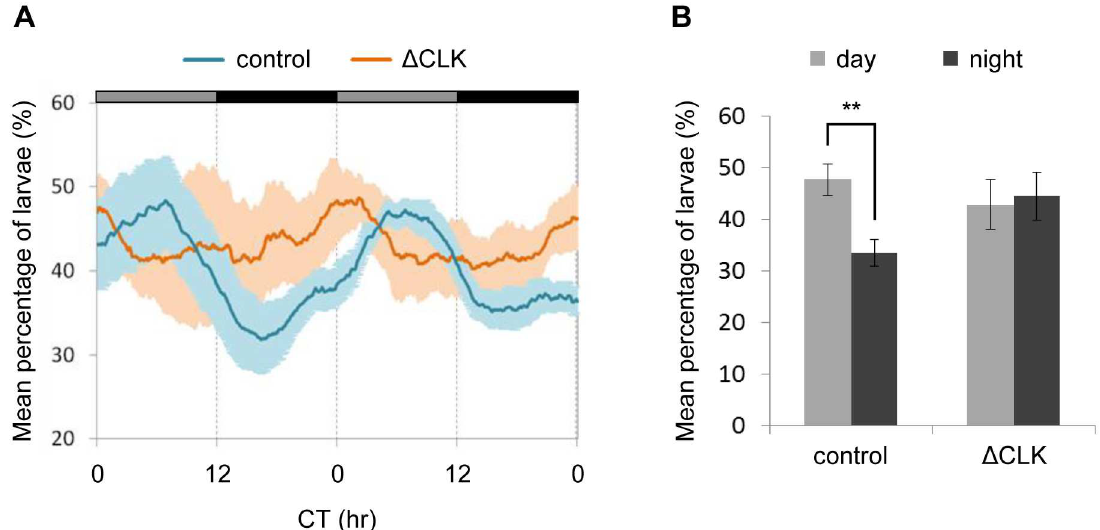
Fig 8. Clock-controlled rhythms of place preferenceare eliminated by blocking the pineal clock. Analysis of the vertical position of Tg( aanat2 :EGFP- Δ CLK) and control larvae in the water column for two daily cycles under DD, after entrainment by 4 LD cycles. (A) The mean percentage of larvae within the top third of the water column is plotted on the y-axis and circadiantime (CT) is plotted on the x-axis. Error bars represent SE [ n = 4 groups of 15 Tg( aanat2 :EGFP- Δ CLK) larvae, and 8 groupsof 15 control larvae]. Gray and black horizontal bars represent subjective day and subjectivenight, respectively.A significant difference in distribution of the G-factors (see ’Fourier analysis’in S1 Text) was revealedbetweenTg( aanat2 :EGFP- Δ CLK) and control larvae ( p < 0.05,Kolmogorov-Smirnov test). (B) The mean percentage of larvae in the top third of the water column at CT 5–6 (subjectiveday) and CT 17–18 (subjectivenight) is summarizedfor two daily cycles under DD. Significantday/night differencesare observed in control larvae ( ** p < 0.01, paired t -test with Bonferroni correction) but not in Δ CLK